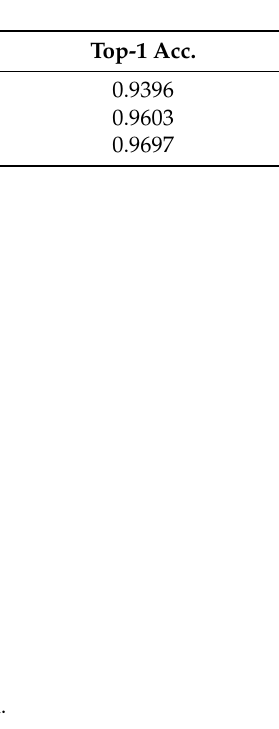
Table 4. Comparison with earlier methods from literature on AUC